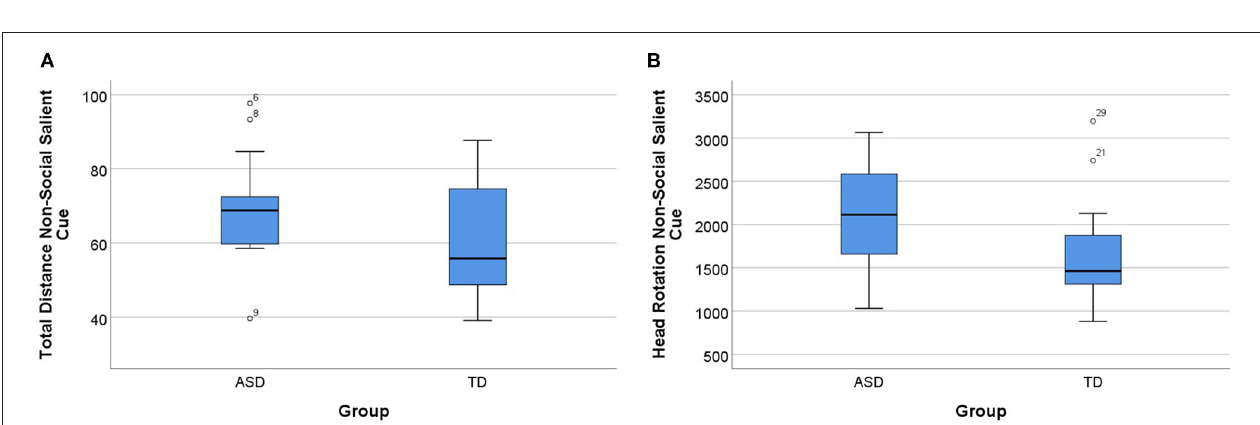
FIGURE 5 | Significant group differences were observed in the non-social cue condition ( p = 0.021). Head rotation for ASD and TD groups for the non-social cue condition. Boxplots: central mark—median; edges of box − 25th and 75th percentiles; whiskers—most extreme data points (minimum and maximum). ASD, autism spectrum disorder group; TD, typical neurodevelopment group.